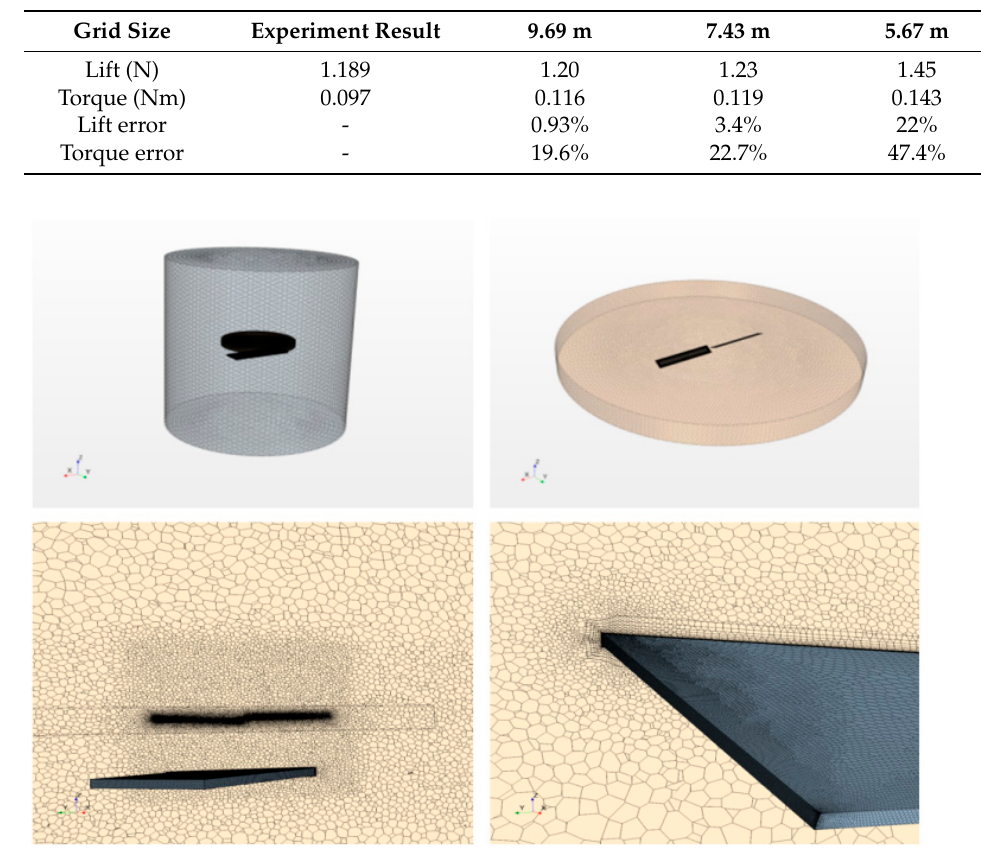
Table 3. Time-averaged lift and torque of different grid size.